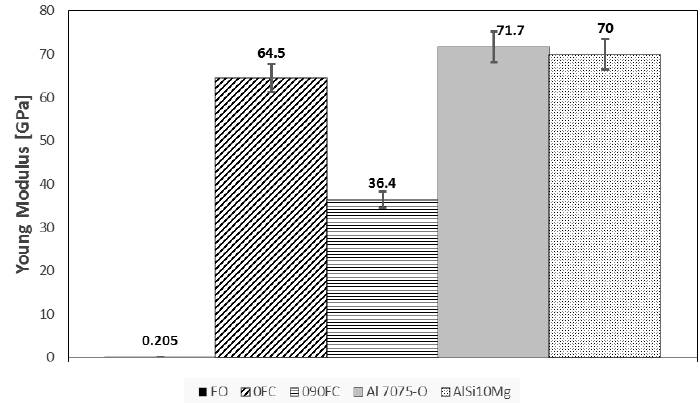
Figure 6. Tensile Young’s modulus for all systems.